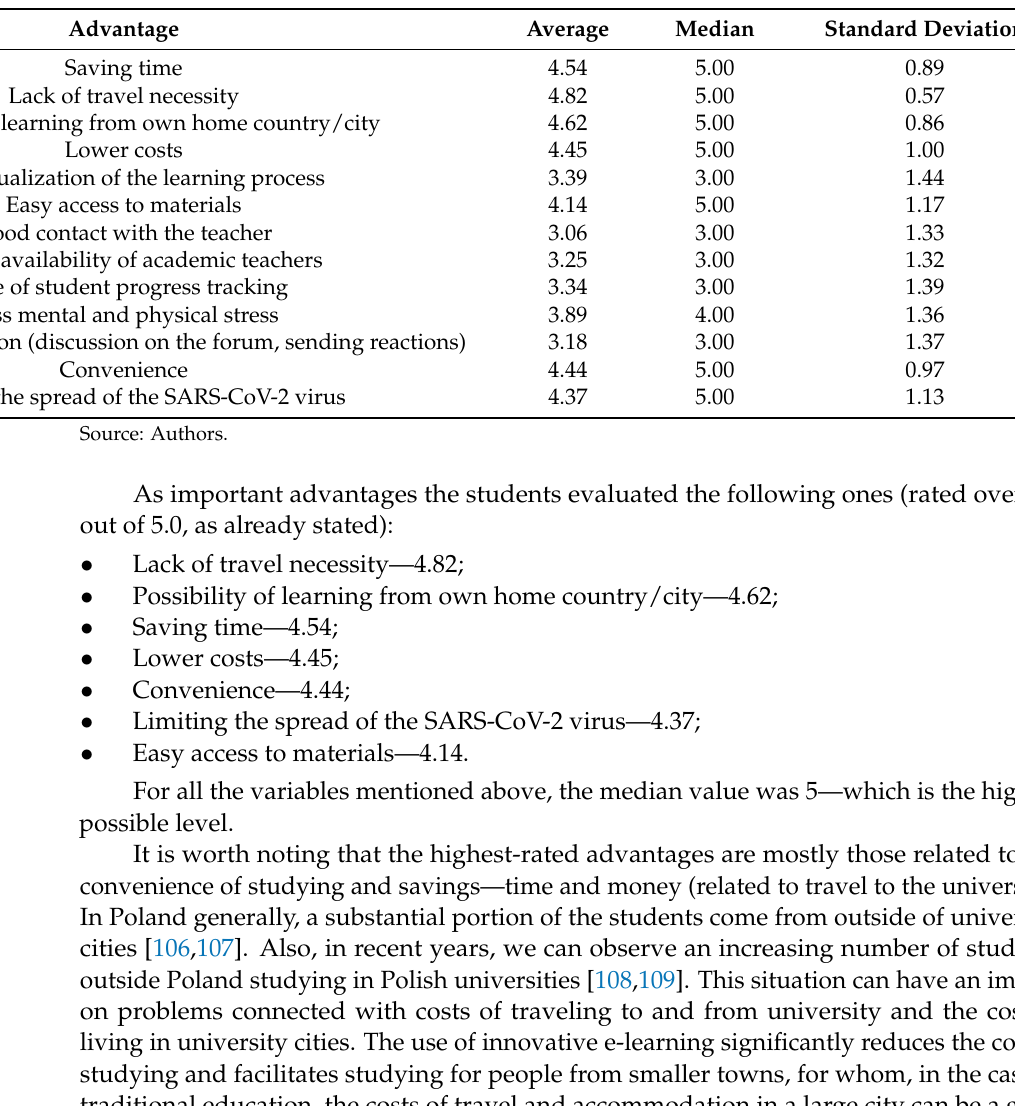
Table 1. The advantages of innovative e-learning in higher